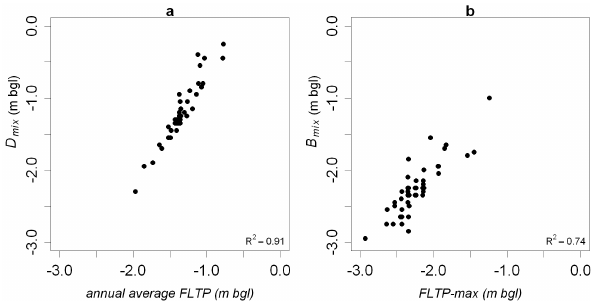
Fig. 16. Scatter diagrams of calculated vertical flow tipping points (FLTP) and lens characteristics D mix and B mix derived from the results of the different sensitivity models (see Table 2). The FLTP, D mix , and B mix are derived for a location between two